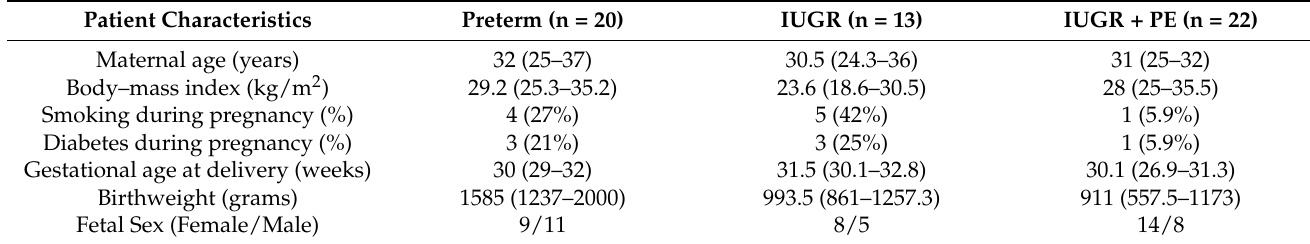
Table 1. Clinical characteristics of <34 week patient cohort.